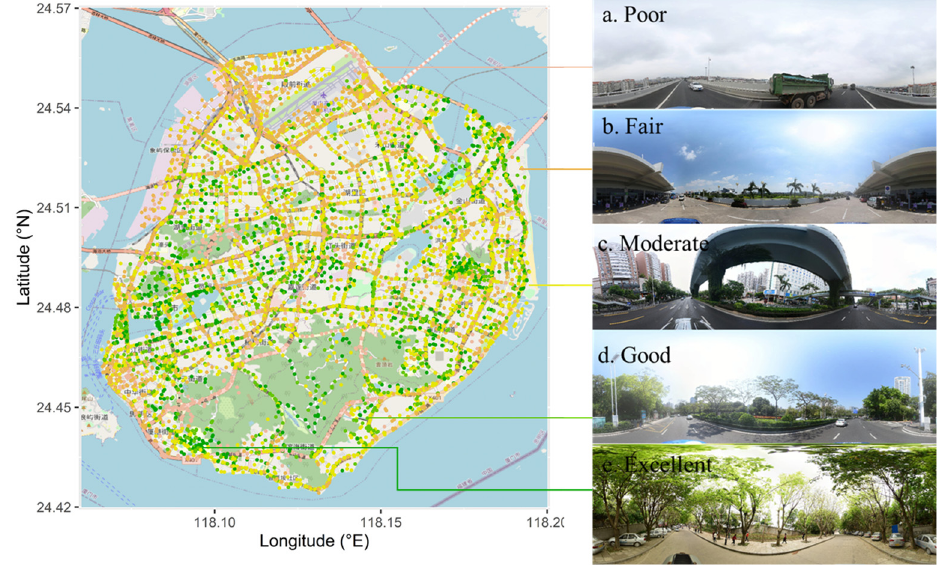
Figure 12. Randomly selected 5 locations to illustrate landscape quality in Xiamen Island.